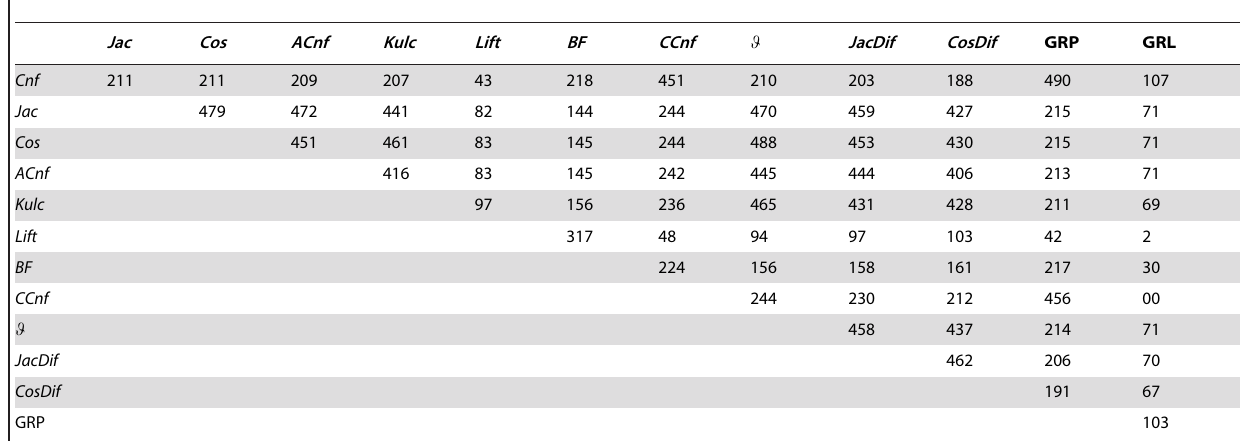
Table 6. The number of intersections for DBpedia-Yago.